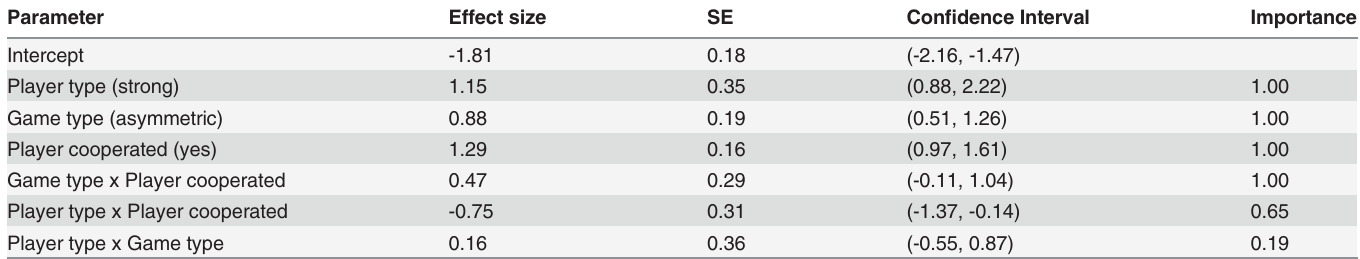
Table 5. Effect sizes, unconditional standard errors, con fi dence intervals and relative importance for parameters included in the top models for the binary response term encoding whether or not players punished their partners for defecting (player did not punish defecting partner = 0, player did punish defecting partner = 1).